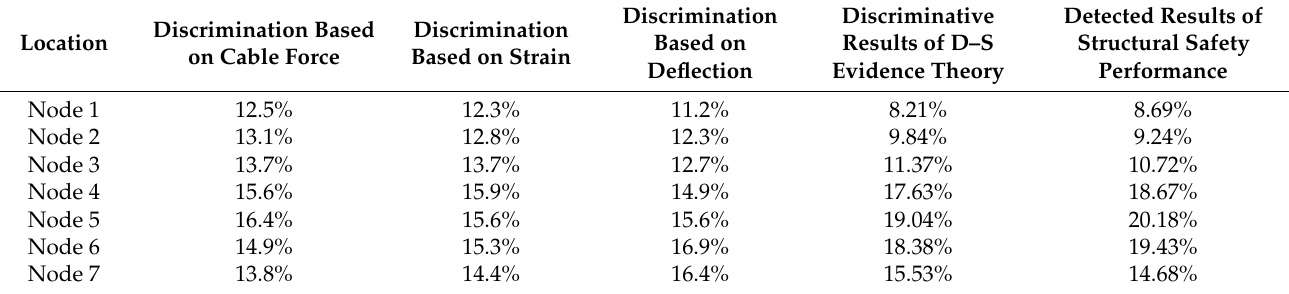
Table 3. Judgment of the sensitivity of each node of the cable.